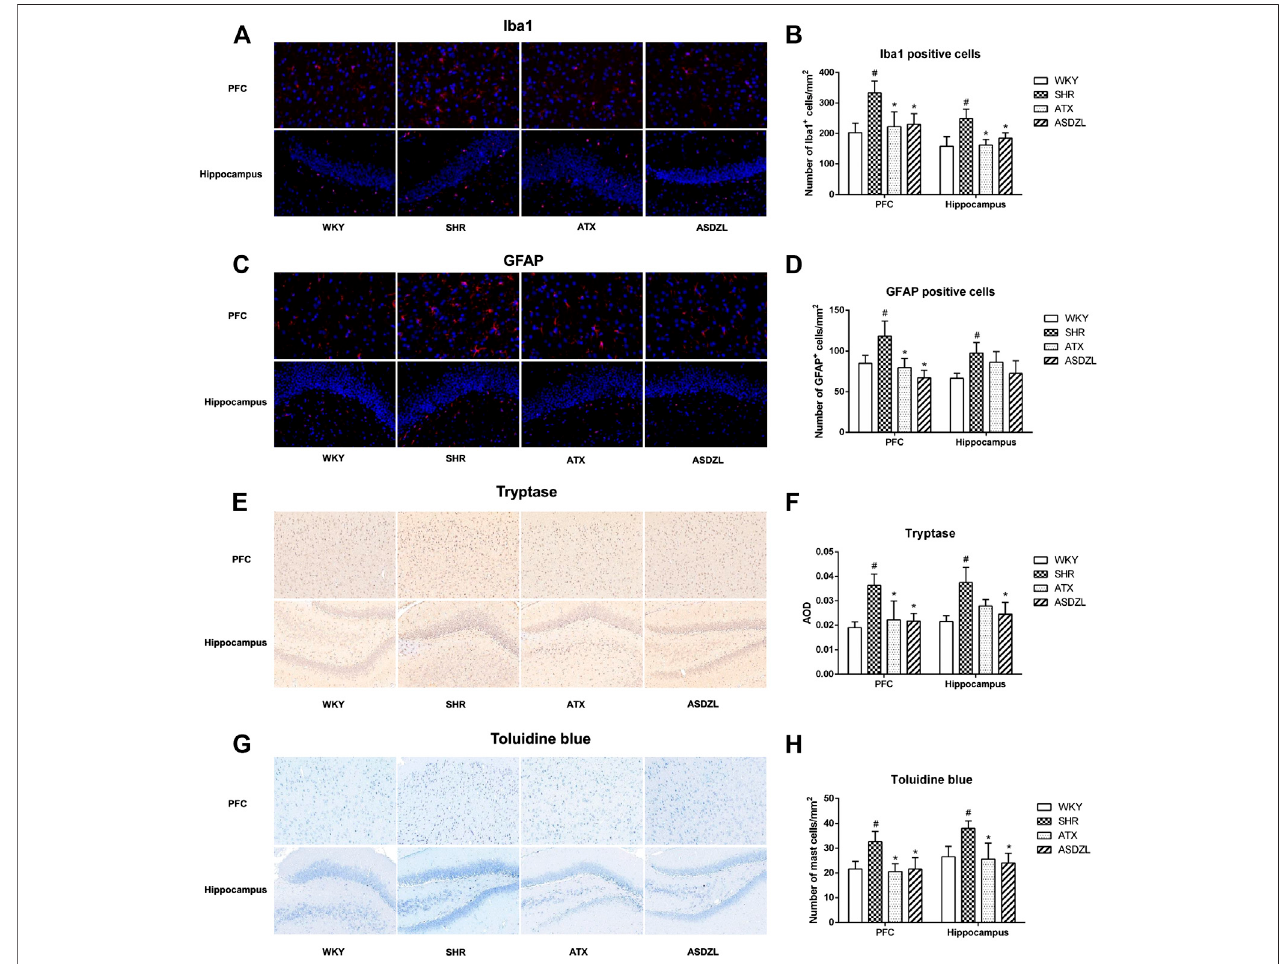
FIGURE 4 | Effect of ASDZL on microglia, astrocytes and mast cells. (A) Representative images of Iba1-immunopositive microglia (red) with DAPI (blue) staining from PFC and hippocampus; (B) Quanti fi cation of Iba1+ cells in the PFC and hippocampus; (C) Representative images of GFAP-immunopositive astrocytes (red) with DAPI (blue) staining from the PFC and hippocampus; (D) Quanti fi cation of GFAP + cells in the PFC and hippocampus; (E) Immunostaining for tryptase in PFC and hippocampus tissues; (F) Relative protein expressions of tryptase were quanti fi ed by AOD; (G) Mast cells in the PFC and hippocampus were stained with toluidine blue (TB); (H) Quanti fi cation of activated mastcells in the PFC and hippocampus. Data were presented asthe mean ± SD, n (cid:2) 3for each group. # p < 0.05 SHRvs. WKY group, *p < 0.05, compared to SHR